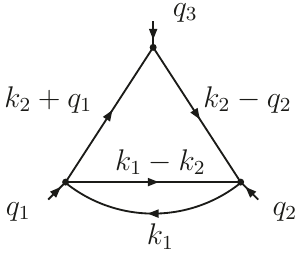
Figure 3 . Diagram corresponding to R ( m 2 1 , m 2 2 , m 2 3 , m 2 4 ; q 2 1 , q 2 2 , q 2 3